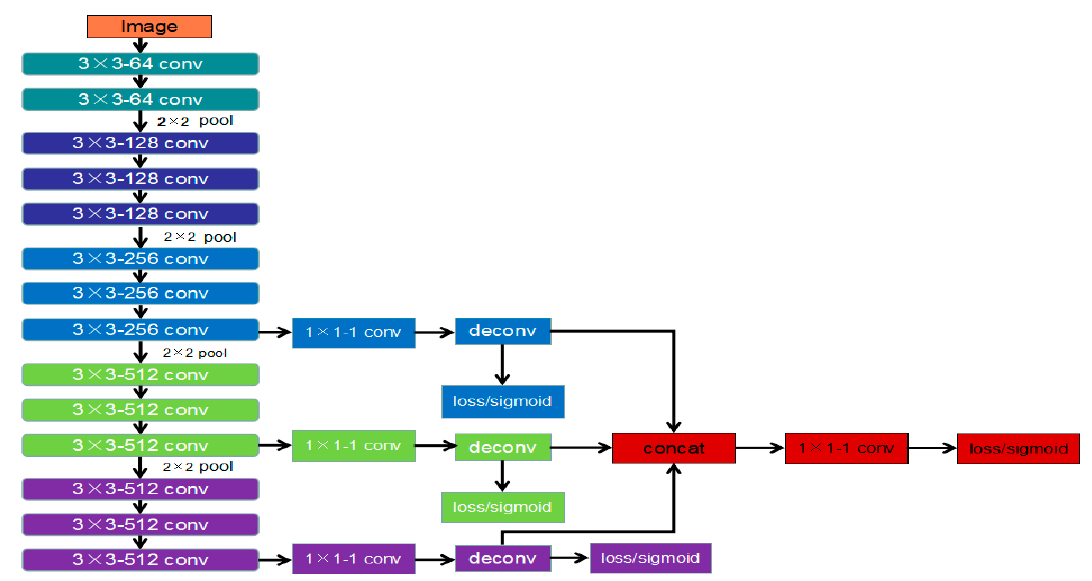
Figure 9. Architecture of the proposed improved holistically nested edge detection (IHED) network.